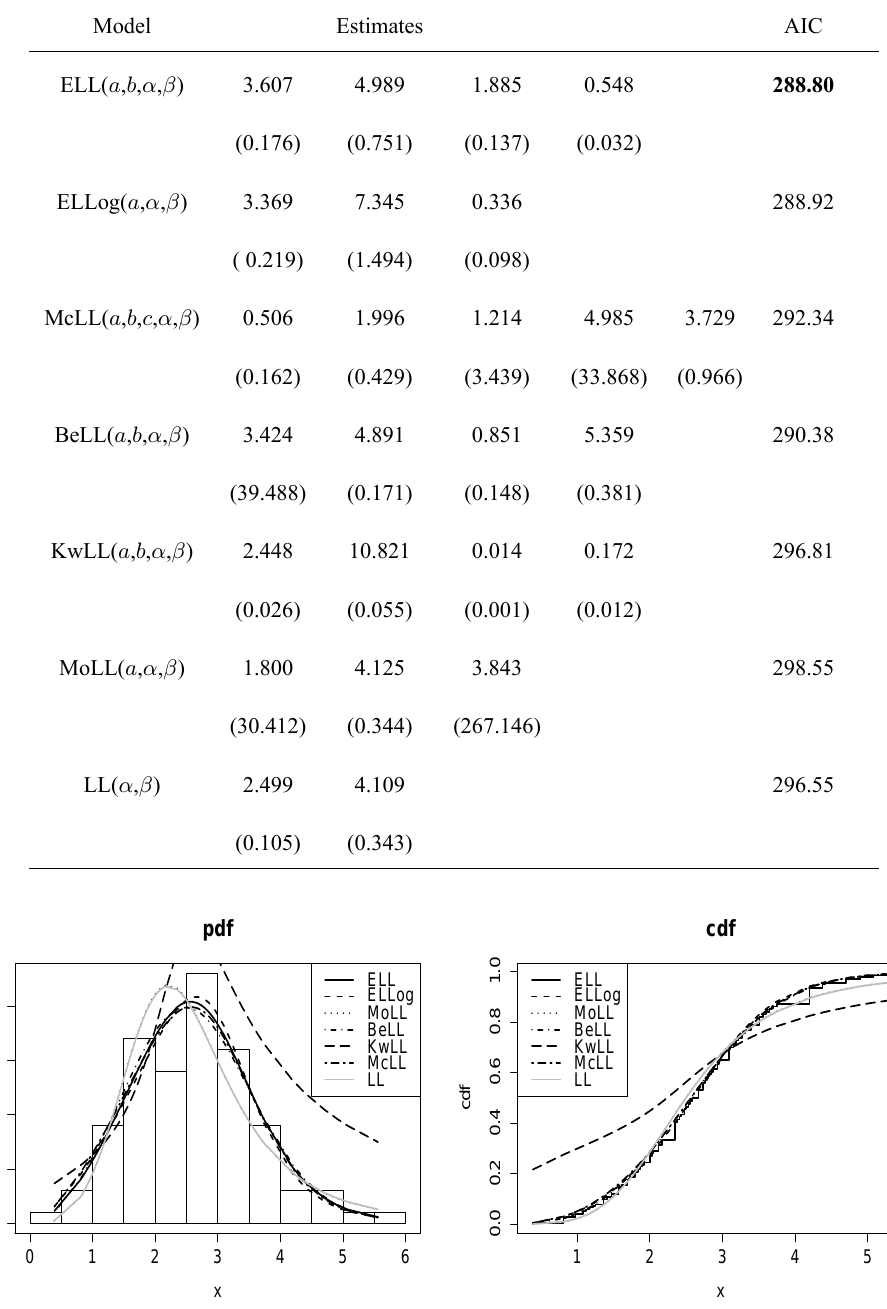
The MLEs (standard errors in parentheses) of the model parameters.